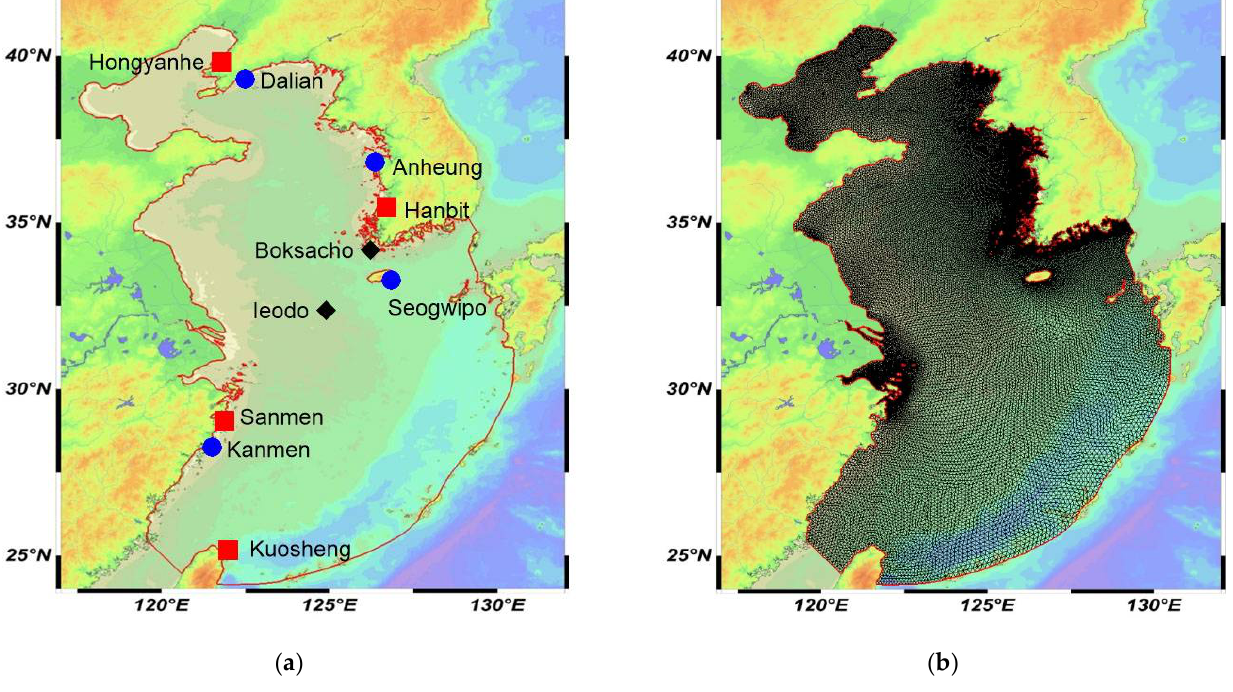
Figure 3. ( a ) Modeling domain with locations of tidal stations (blue circles), wave buoys (black diamonds), and NPPs (red squares). ( b ) Mesh for hydrodynamic simulations.